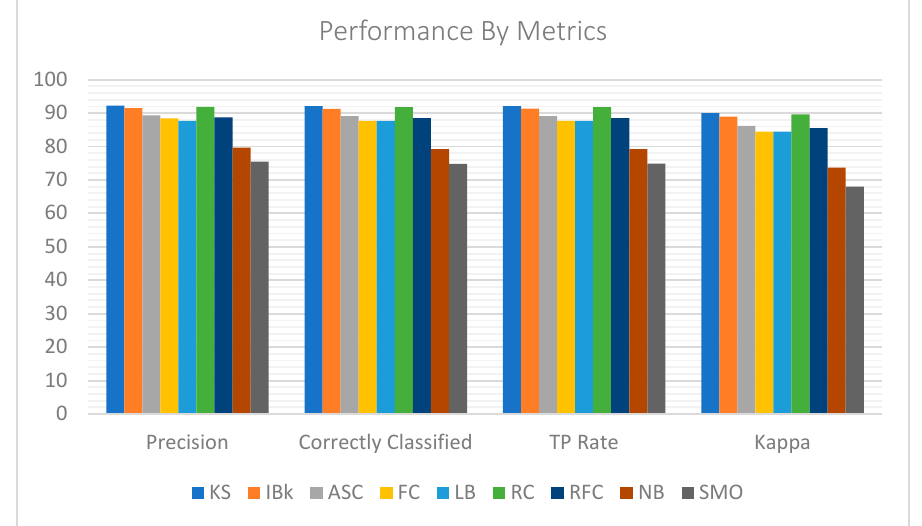
Figure 13. Comparison of classifiers’ performance (grouped into the performance metrics).